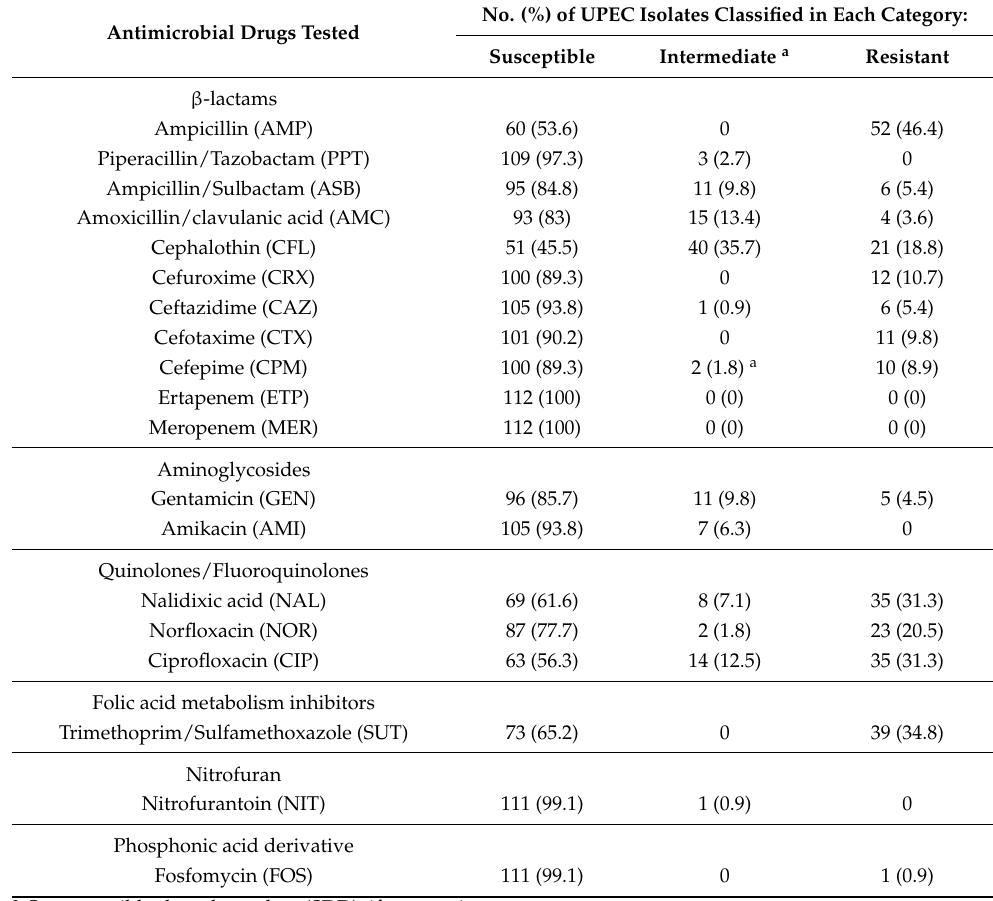
Table 4. Antimicrobial resistance of the uropathogenic E. coli (UPEC) isolates studied. No. (%) of UPEC Isolates Classified in Each Antimicrobial Drugs Tested